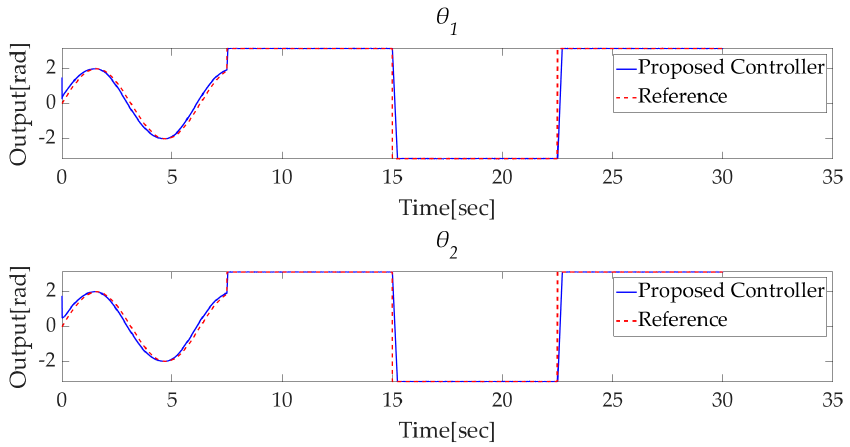
Figure 18. RT-NTSMC-NN controller performance for mixed input.